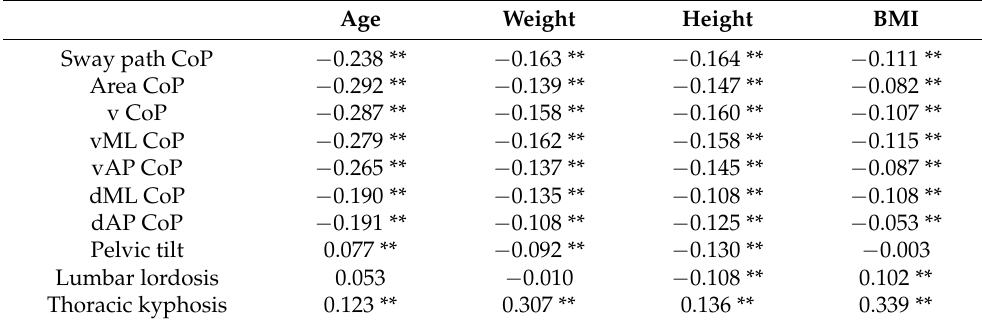
Table 3. Pearson correlation between anthropometric variables and stabilometry and angular variables. Age